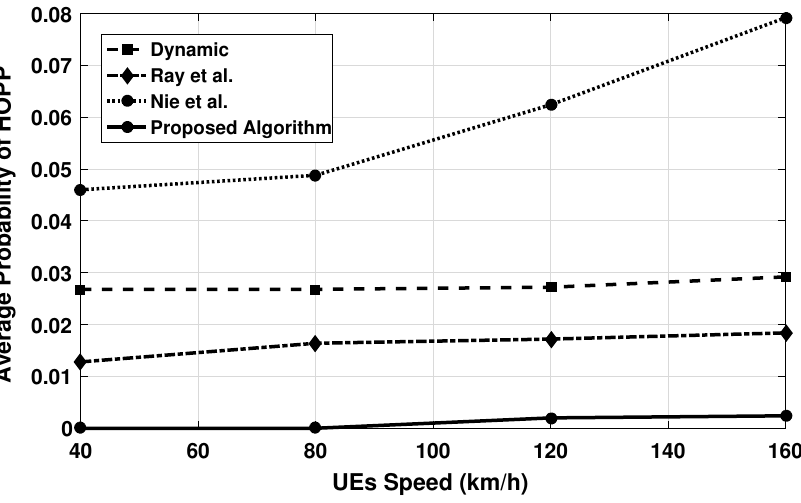
Figure 7. Average probability of HOPP with varying UE